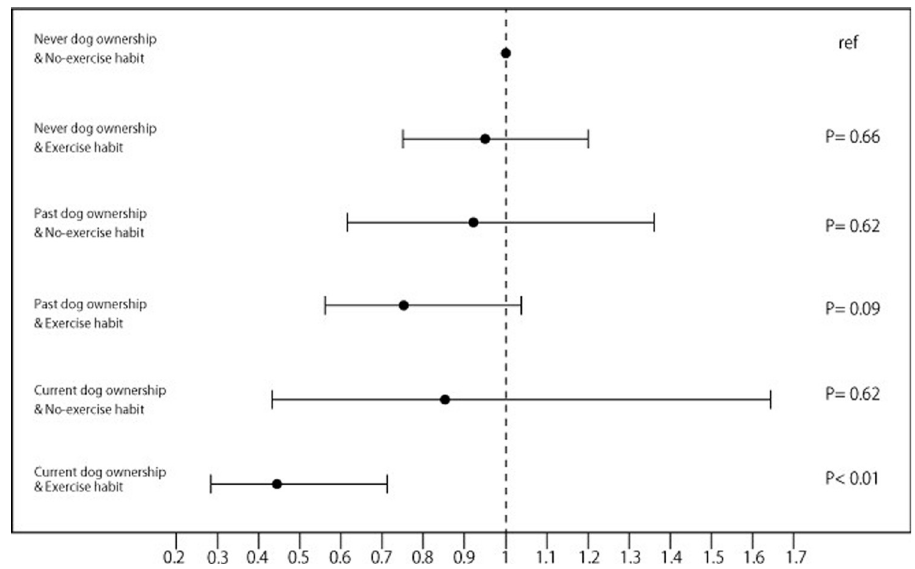
(history of hypertension, heart disease, stroke, diabetes mellitus, lung respiratory disease, and cancer, alcohol drinking and smoking status, food variety, frailty, Geriatric Depression Scale), and follow-up period.